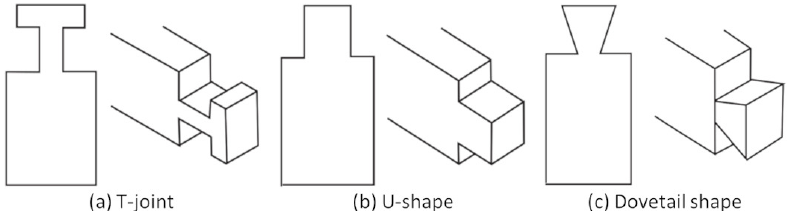
Figure 3. Types of Interface analyzed by Ribeiro et al. [6]: ( a ) T-shape, ( b ) U-shape, and ( c ) Dove- tail